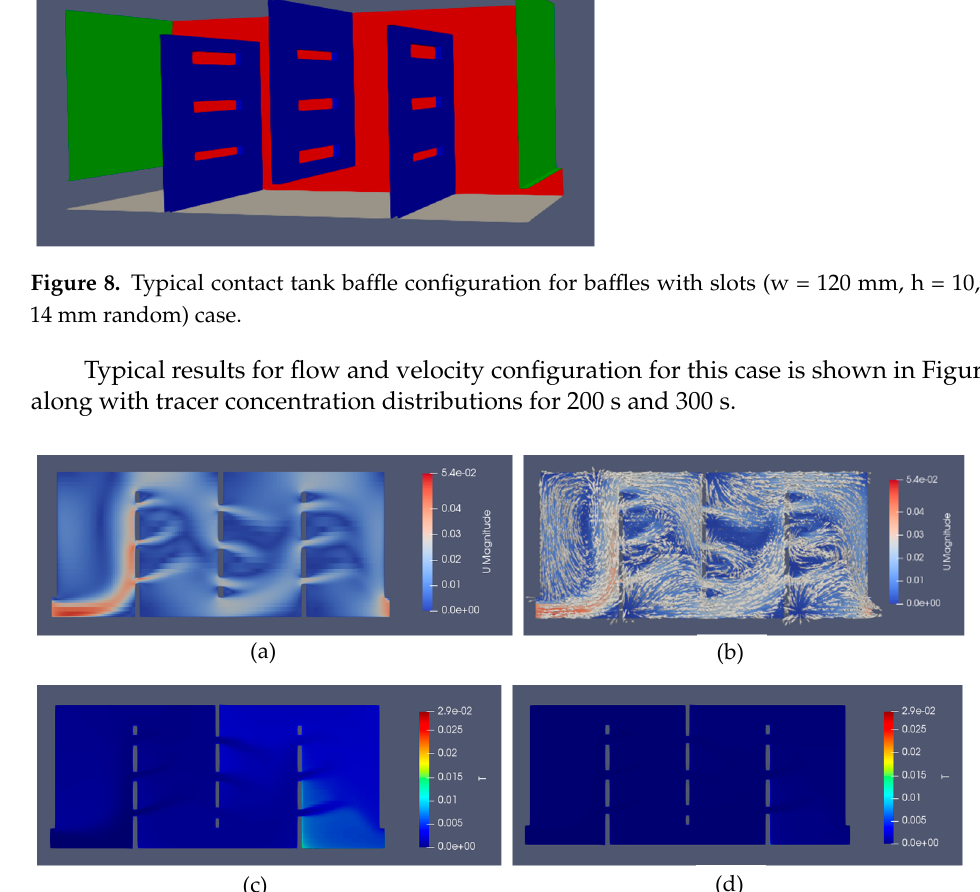
Figure 10. E( θ ) and F( θ ) plots obtained from tracer simulations for contact tank with finite width slots and classic design cases.